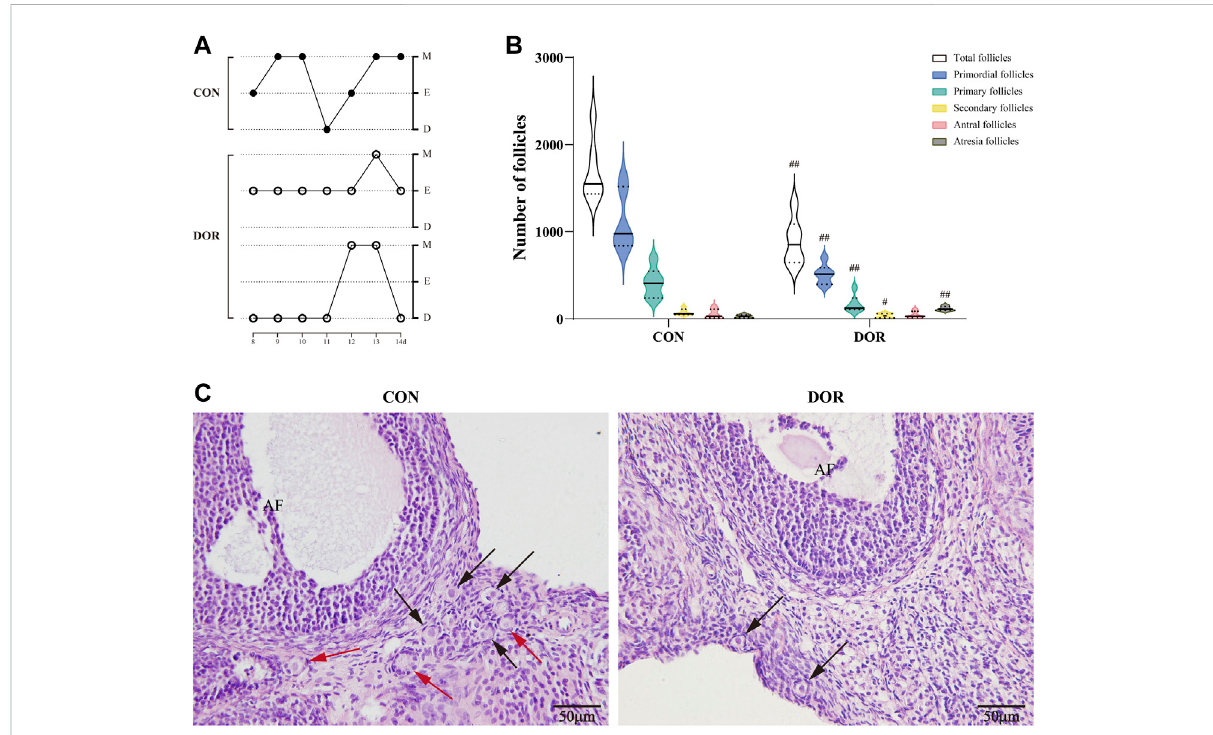
FIGURE 1 DOR rats exhibit disordered estrous cycles and a decline in ovarian reserve. (A) Estrous cycles from day 8 to 14. (B) Number of follicles in the CON and DOR groups; compared with CON, ## p < 0.01, # p < 0.05. (C) Representative photographs of HE staining of ovarian slices. Black arrows indicate primordial follicles, and red arrows indicate primary follicles; AF, antral follicles; scale bar = 50 µm. n = 6. CON, control group; DOR, diminished ovarian reserve; HE, hematoxylin and